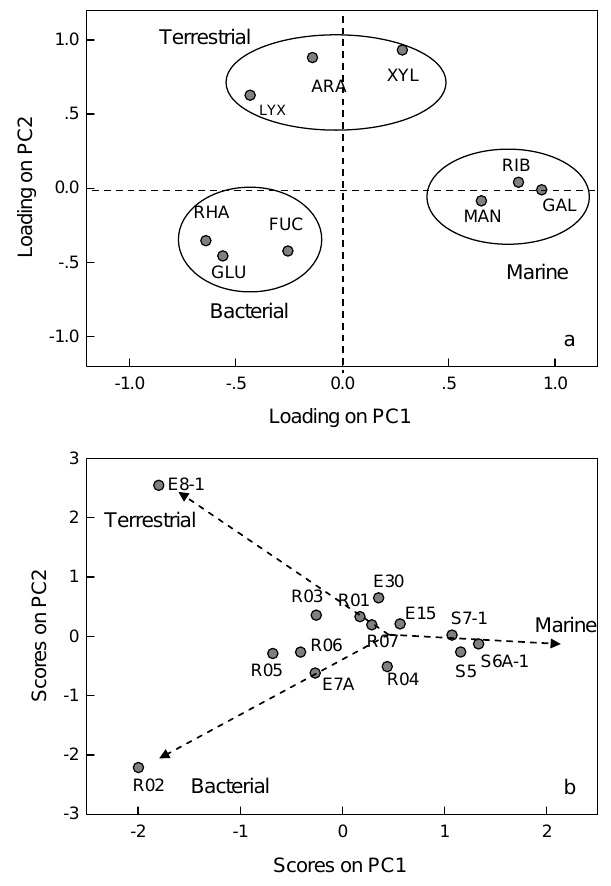
Fig. 9. (a) The loadings on the two principal components for all neutral sugars, and (b) the scores of the two principal components for each sampling